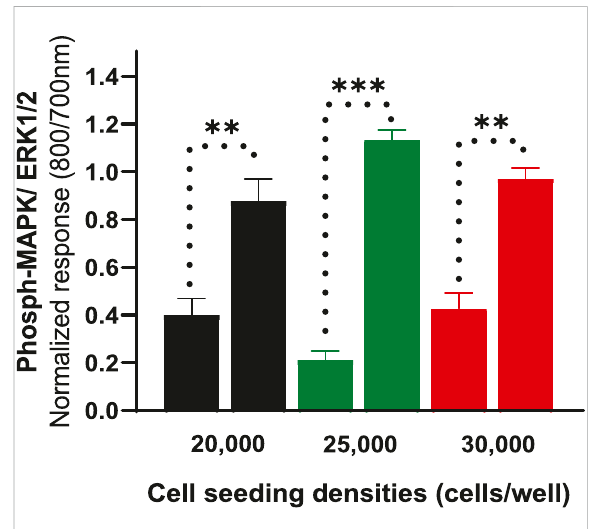
FIGURE 3 Effect of cell seeding densities (20,000, 25,000 and 30,000 cells per well) expressed as normalized data showing values for basal and their corresponding SNC80 stimulated ERK phosphorylation. The data shown are the means of triplicate measures ± SEM. Statistical signi fi cance was determined using a paired two-tailed t-test; ** p < 0.01, *** p <